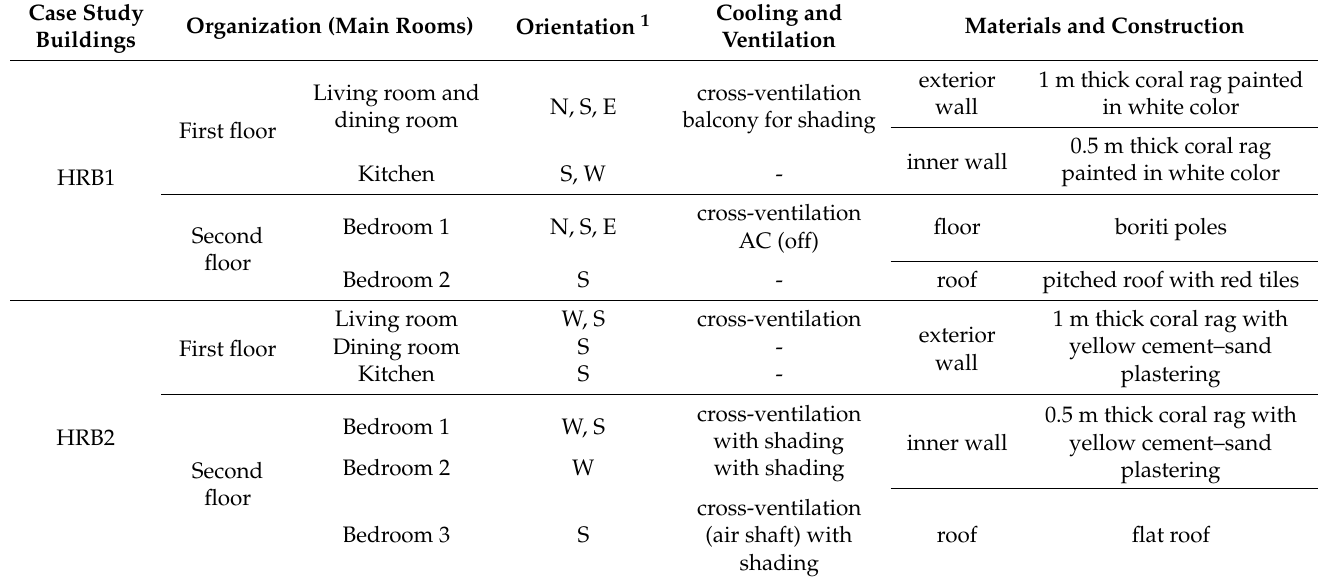
Table 2. Passive cooling features of case study buildings HRB1 and